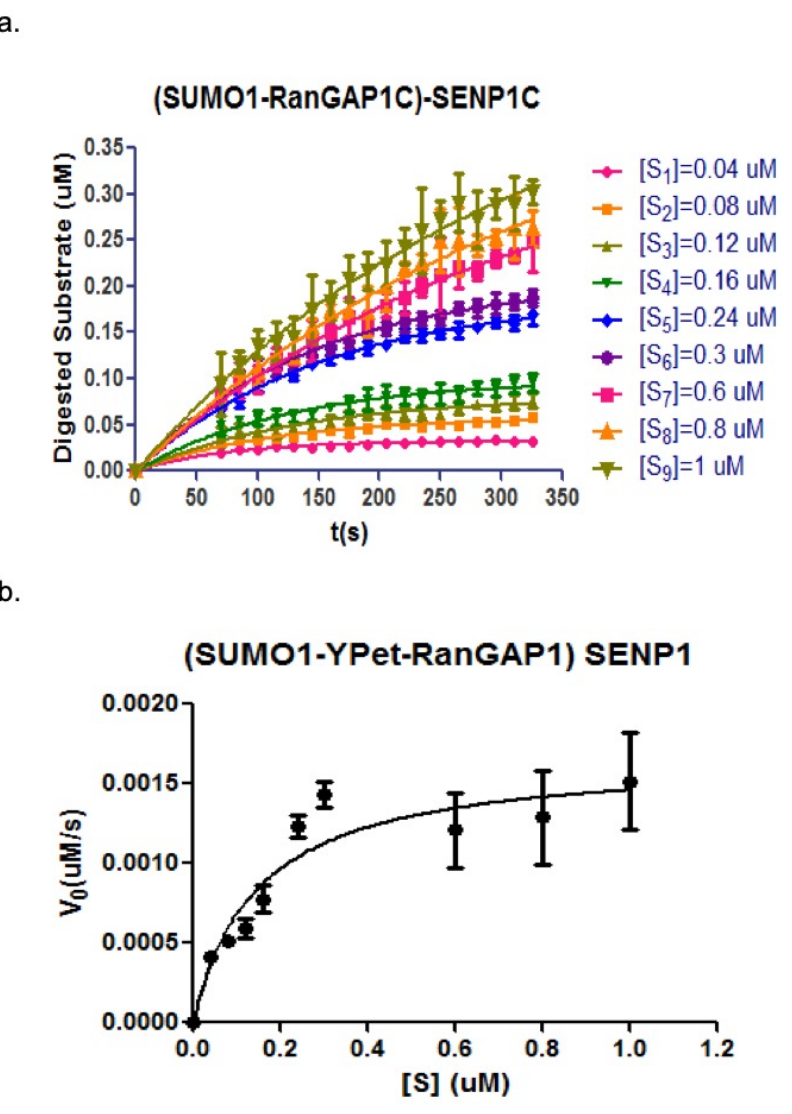
Figure 7. QFRET analysis in study the protease kinetics of SUMO1-RanGAP1C deconjugation by SENP1C. ( a ) Initial velocities determinations under different substrate concentrations. ( b ) Michaelis–Menten graphical analysis. Data were plotted and analyzed by GraphPad Prism 5 and nonlinear regression (one phase association model for ( a ) and Michaelis–Menten model for ( b )). Table 2. The initial velocity ( v 0 ) of SUMO1-RanGAP1C deconjugation by SENP1C derived by qFRET